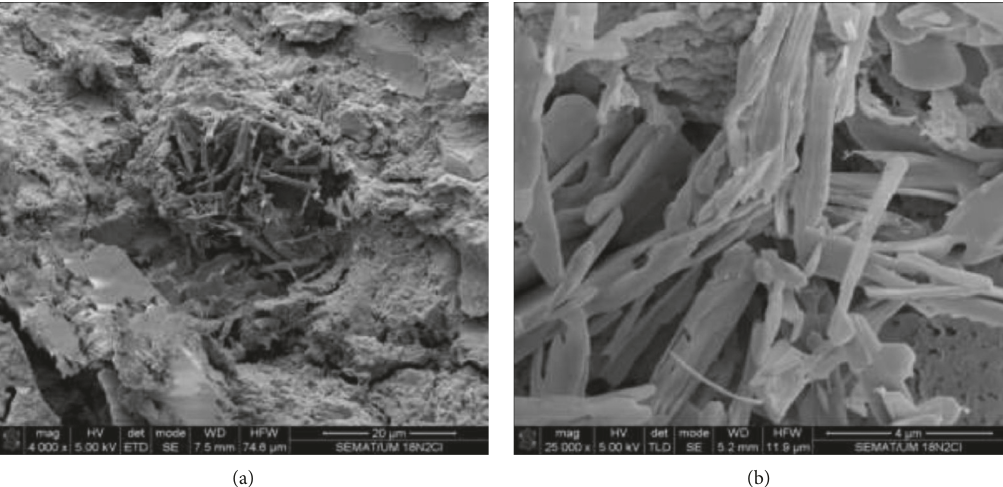
Figure 10: (a) The SEM shot of the concrete treated with coat after 18months in liquid NaCl environment; (b) a detail of the formed Friedel’s salt crystals (3CaO · Al 2 O 3 · CaCl 2 · 10H 2